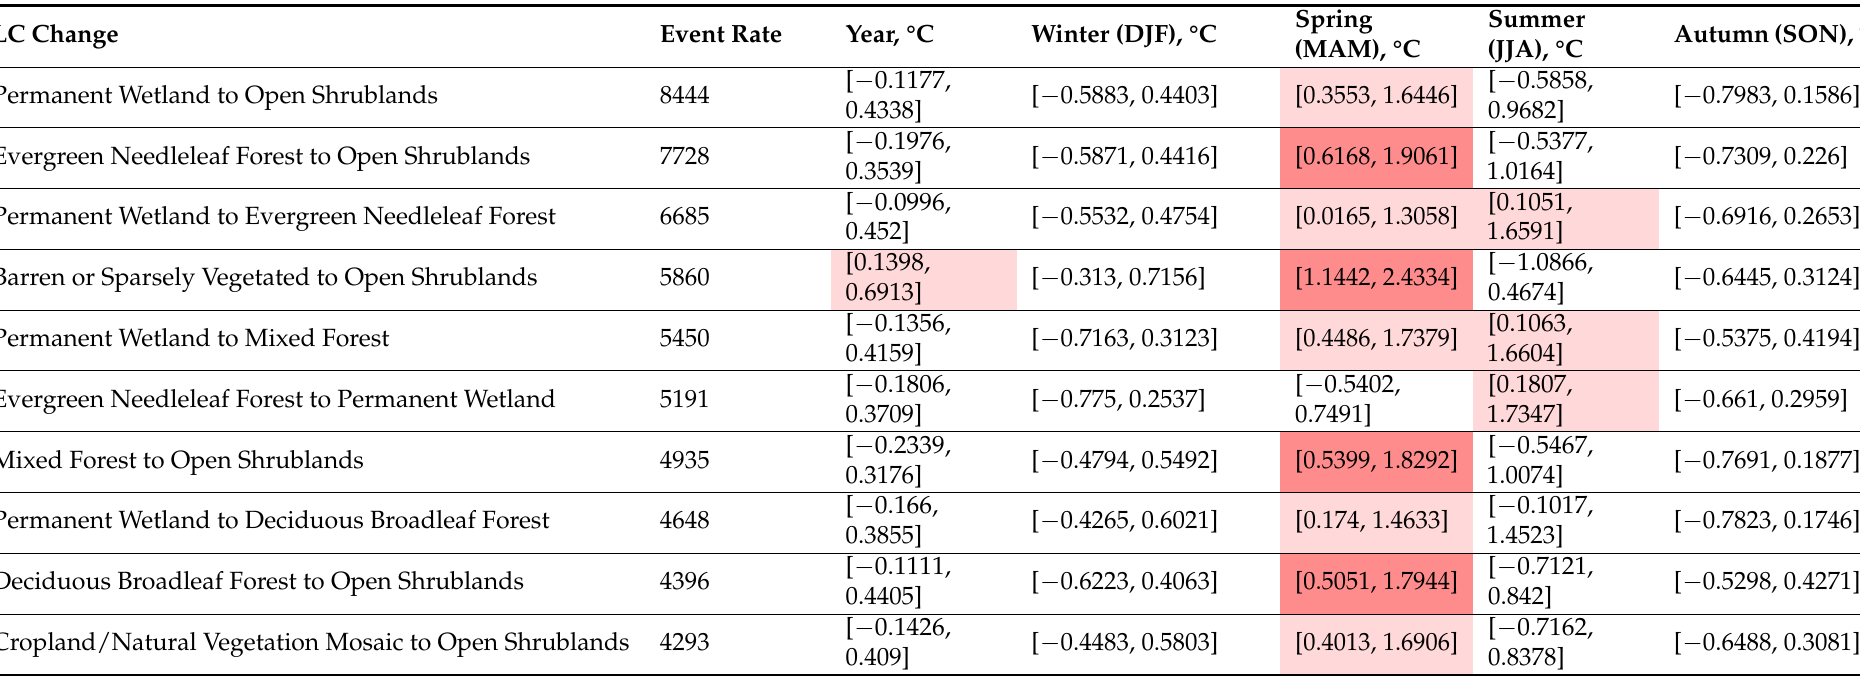
Table A1. Temperature changes in northern Europe depending on LC transformation. Blue and red cells represent LC changes resulting in statistically significant cooling and warming, respectively. Intense red cells show cells where LC changes resulted in at least a 0.5 °C temperature change with 95%